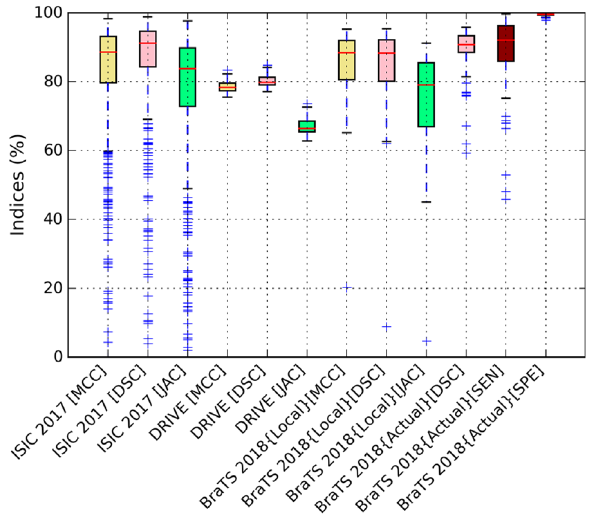
Figure 9. Boxplots of the segmentation performances of each testing data via the proposed CMM-Net.